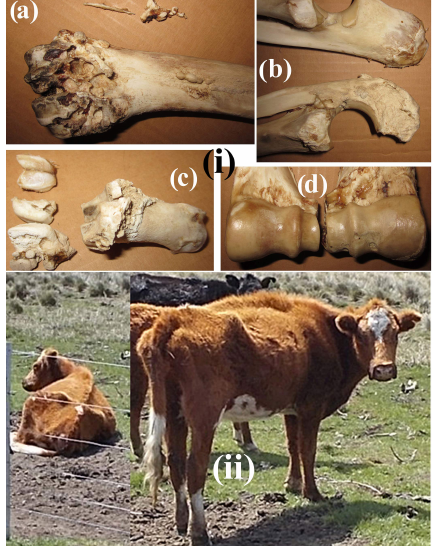
Figure 3. (i) Skeletal fluorosis in deer: (a) deformed metacarpal with exostoses and calcified tendons, (b) ulna with various patholo- gies next to a normal one, (c) proximal sesamoid bones and first phalange with exostoses, (d) distal humerus with exostoses and eroded articulation next to normal one. (ii) Numerous periparturi- ent cattle died in early spring of 2015 even though the winter had been very mild. This cow could barely stand up and make a few